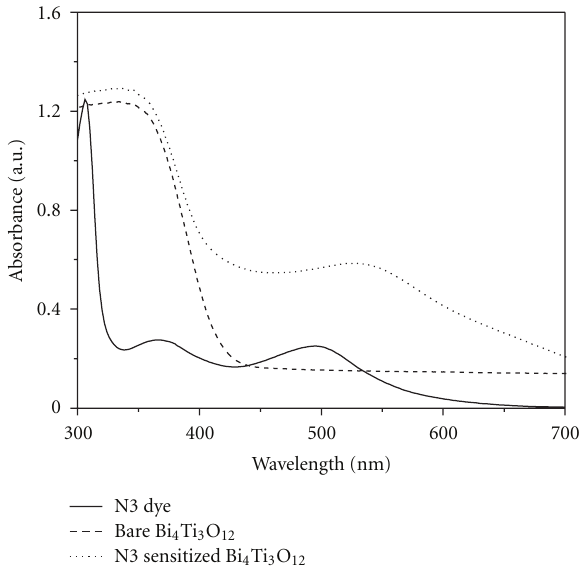
Figure 3: UV-vis absorption spectra of N3 (curve a), Bi 4 Ti 3 O 12 nanoparticles (curve b), and N3 sensitized Bi 4 Ti 3 O 12 nanoparticles (curve c).